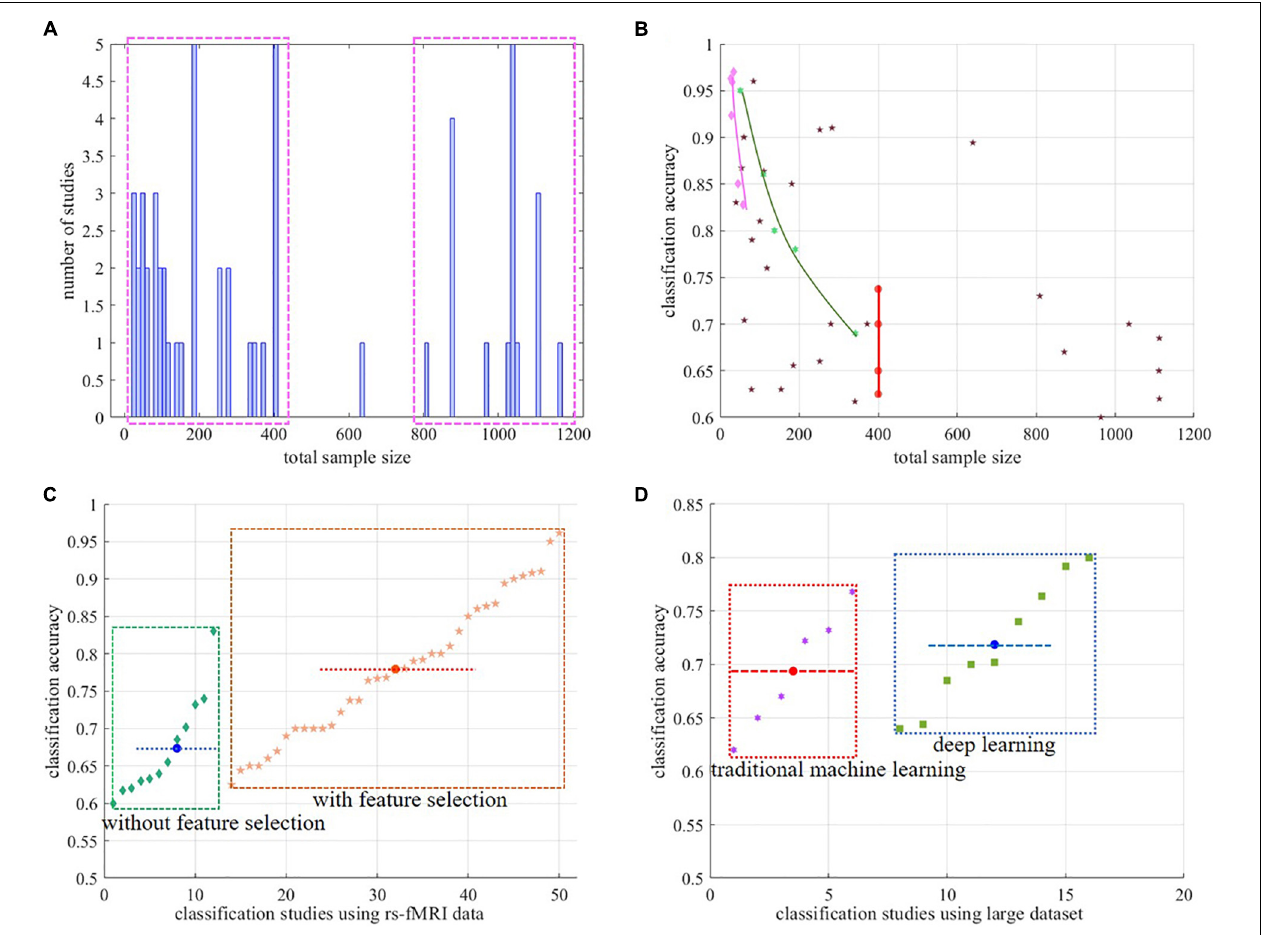
FIGURE 2 | Summary of the involved literatures (A) relationship between number of studies and total sample size. (B) relationship between classification accuracy and total sample size. The pink diamonds and the others represent the task-based fMRI literatures and the rs-fMRI literatures, respectively. The red dots denote the same classification results by Reiter et al. (2021) and Fredo et al. (2019). The green hexagons denote the classification results of Kazeminejad and Sotero (2020). (C) Classification accuracy comparison of studies with feature selection and not, regarding the rs-fMRI dataset. (D) Classification accuracy comparison of studies with deep learning and not, regarding the rs-fMRI dataset with more than 800 participants. fMRI, functional magnetic resonance imaging; rs-fMRI, resting state